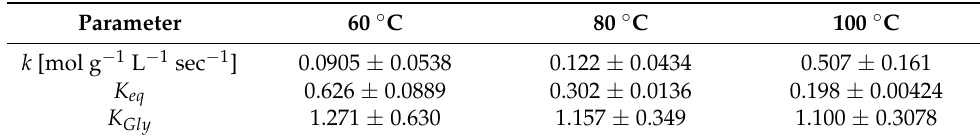
Table 7. Kinetic parameters.